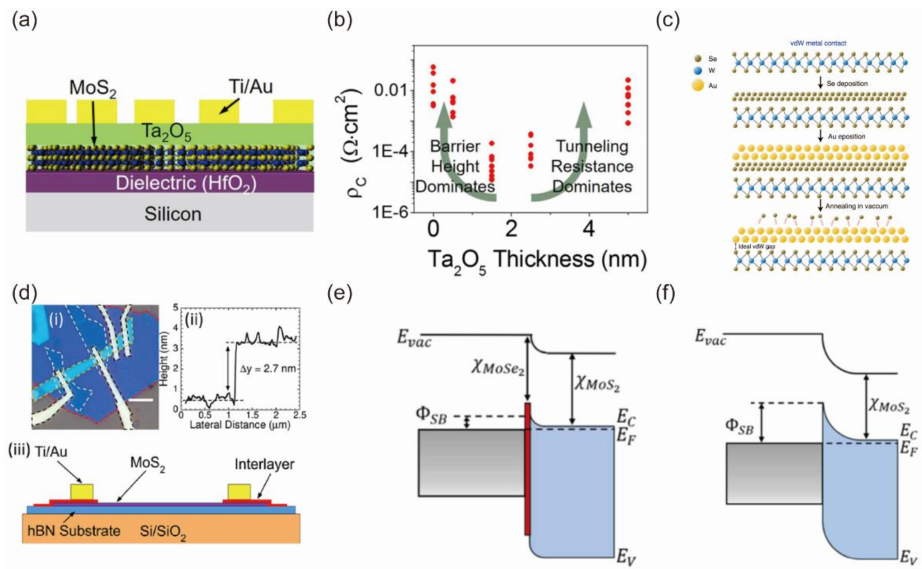
Figure 7. ( a ) Schematic of MoS 2 FETs with various thicknesses of Ta 2 O 5 interlayer. ( b ) Measured specific contact resistivity as a function of Ta 2 O 5 dielectric thickness. Reprinted/adapted with permission from Ref. [84]. Copyright 2016, American Chemical Society. ( c ) Schematic of vdW Au contact WSe 2 fabrication process. Reprinted/adapted with permission from Ref. [88]. Copyright 2022, Springer Nature. ( d ) (i) Optical micrograph of MoS 2 FETs with MoSe 2 interlayers. (ii) Thickness analysis of the MoSe 2 interlayers. (iii) Device structure of MoS 2 FETs with Ti/MoSe 2 interlayer contacts. Illustrations of the band alignments at the contacts with a MoSe 2 interlayer ( e ) and direct metal contacts ( f ). Reprinted/adapted with permission from Ref. [89]. Copyright 2020, American Chemical